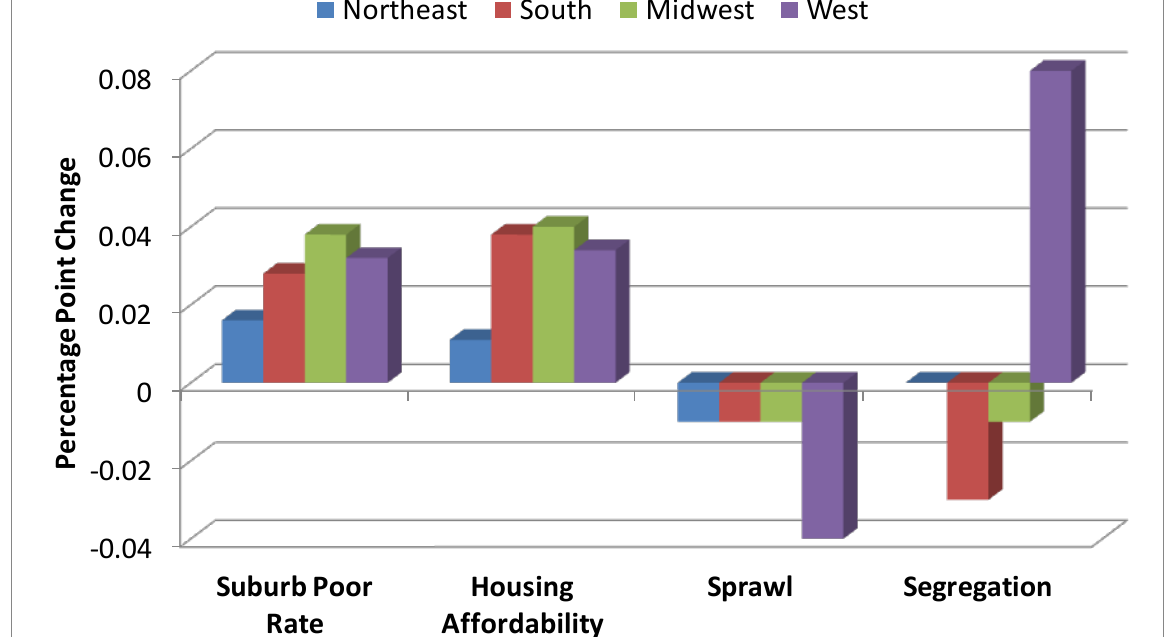
Figure 3. Regional differences in the change of key metropolitan features, 2000 to 2008. Source: author’s analysis of HUD data, Census 2000 and ACS five-year estimates